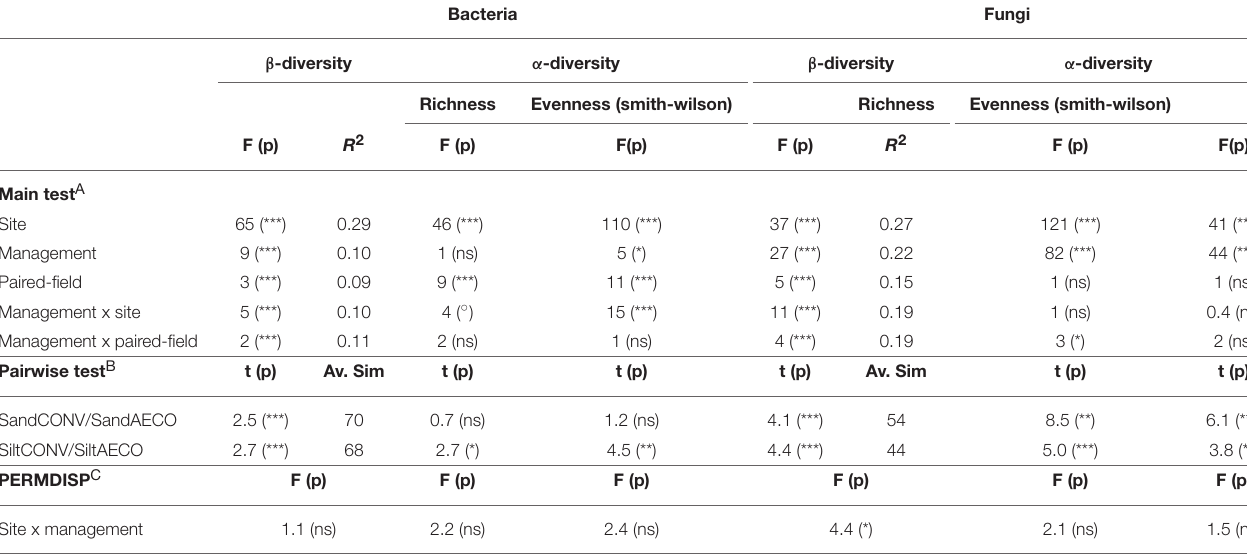
TABLE 2 | Effects of site, management and paired-field on bacterial and fungal β - and α -diversity as assessed by permutational analysis of variance. Bacteria